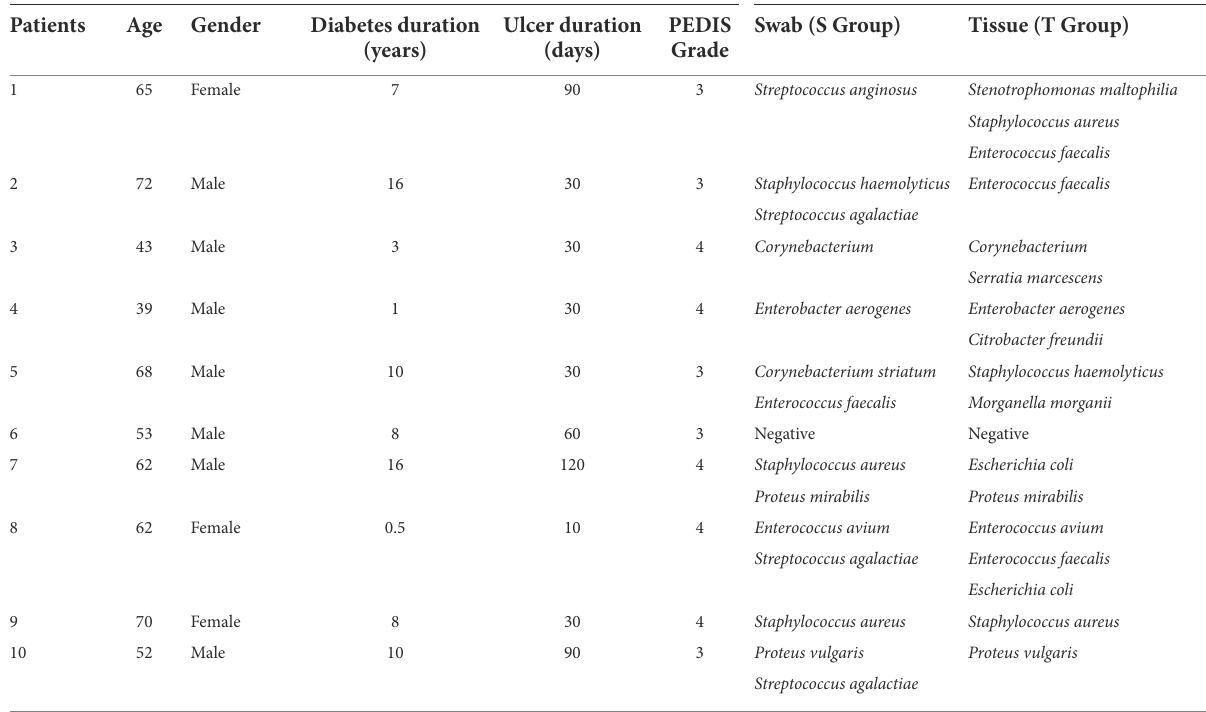
TABLE 1 Clinical data and conventional culture